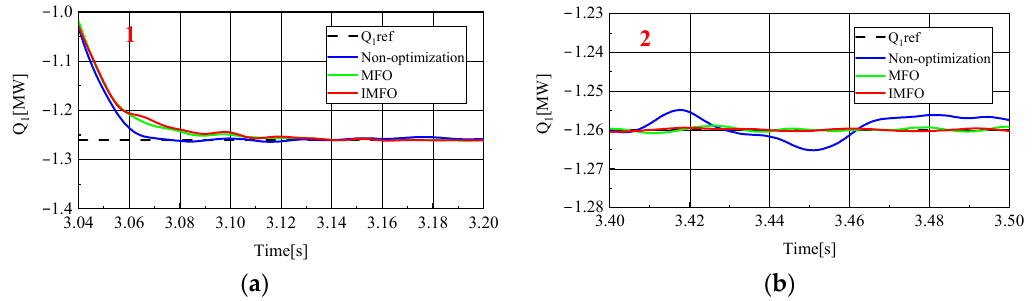
Figure 13. MMC1 reactive power local amplification waveform. ( a ) Locally amplified waveform 1. ( b ) Locally amplified waveform 2.